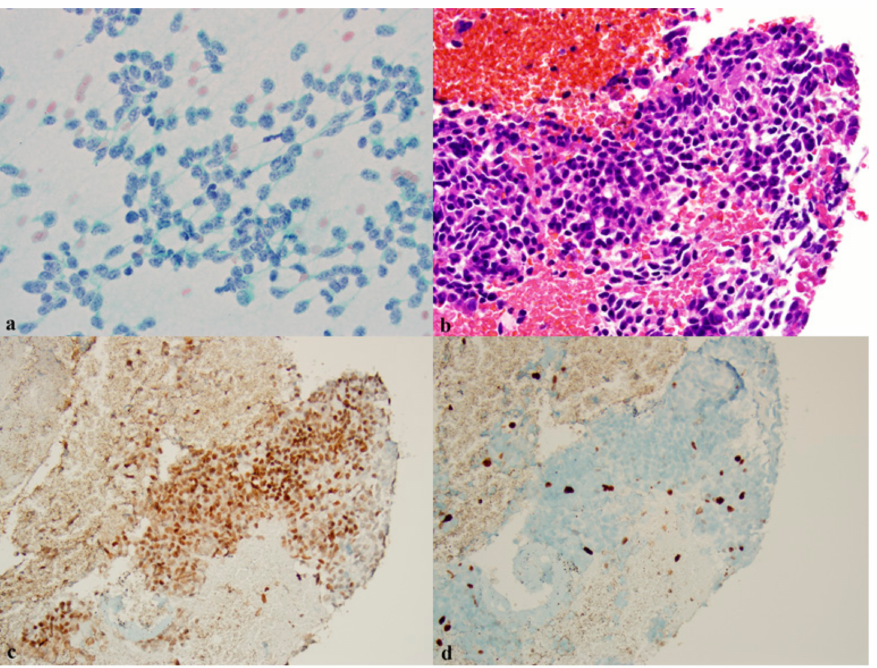
Figure 2. Pulmonary atypical carcinoid. ( a ) Loosely cohesive cells are seen with round to oval nuclei containing coarse chromatin on a smear ( × 400, Papanicolaou stain). ( b ) Cell block shows neoplastic cells and small foci of necrosis ( × 200, H and E stain). ( c ) INSM-1 is positive in most neoplastic cells on cell block ( × 200, IHC). ( d ) KI-67 shows a low proliferation index on cell block ( × 200,